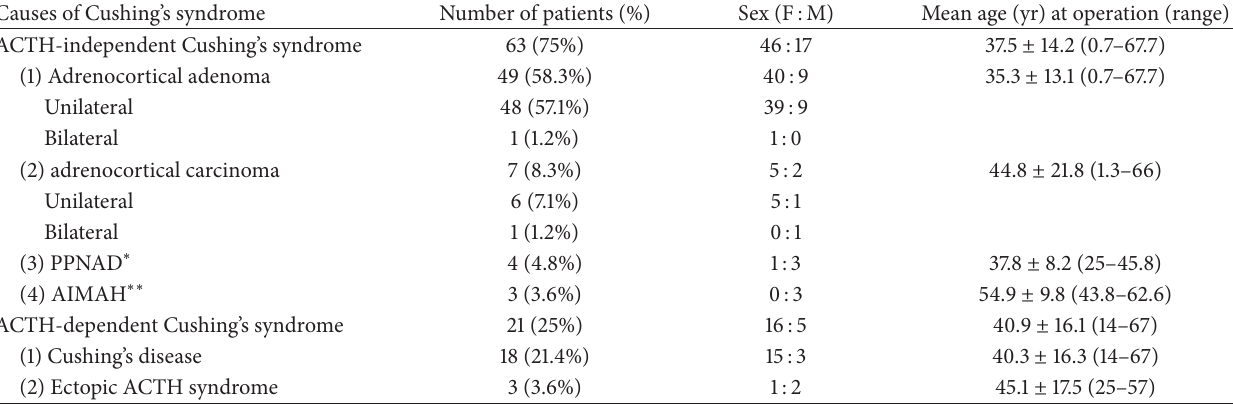
Table 1: Patient distribution and demographic data for the 84 patients with various causes of Cushing’s